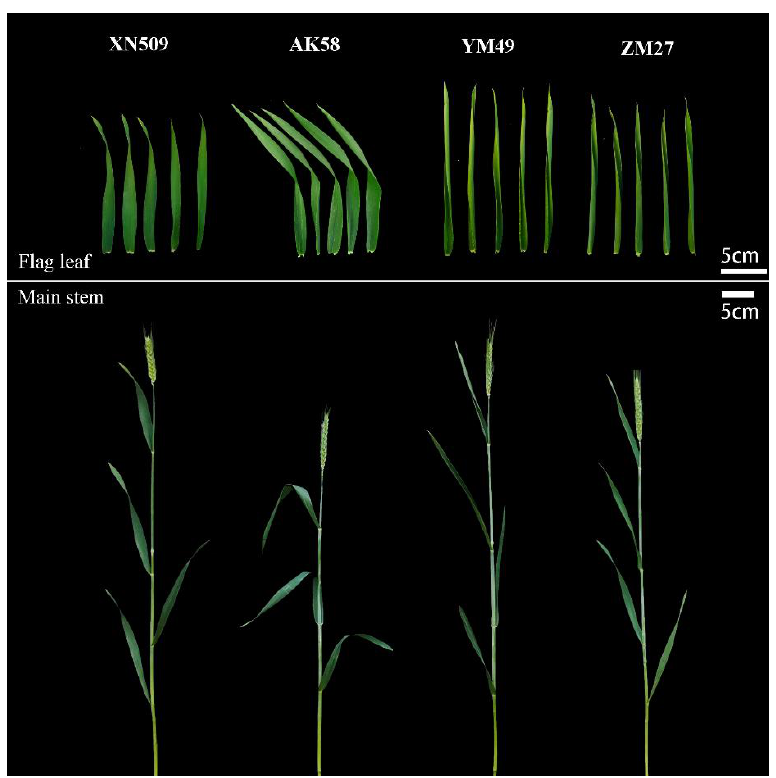
Figure 3. Leaf morphological traits of two N-efficient and N-inefficient winter wheat varieties under 225 kg·hm −2 N. Table 3. Flag leaf morphological traits of two N-efficient and two N-inefficient winter wheat varie- ties under different N levels.